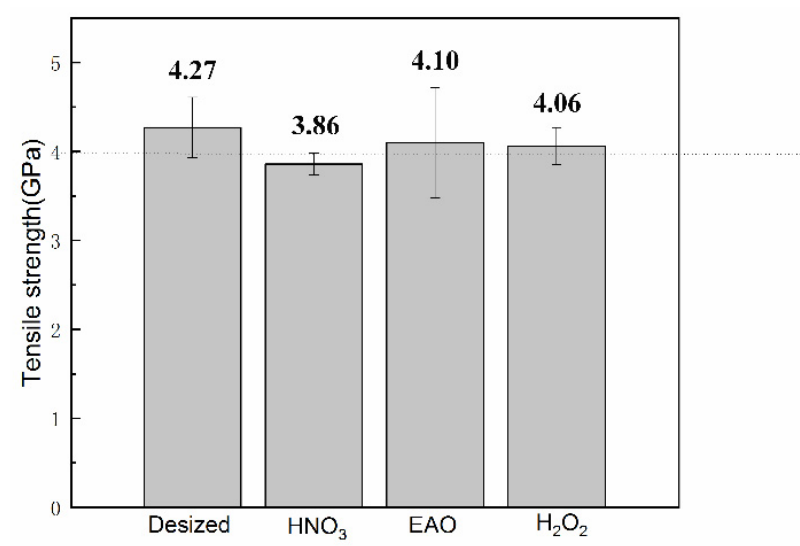
Figure 3. Single-filament tensile strength of CFs obtained using different surface pretreatment methods. (The dotted line in the figure indicates we set 4 GPa as the reference.)